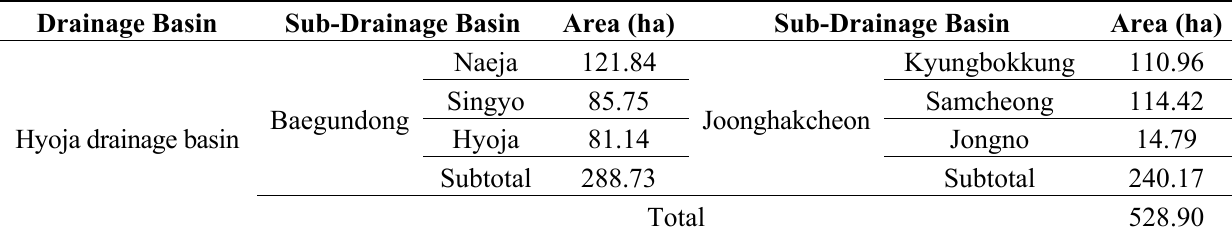
Table 1. The areas of the sub-drainage basins in the Hyoja drainage